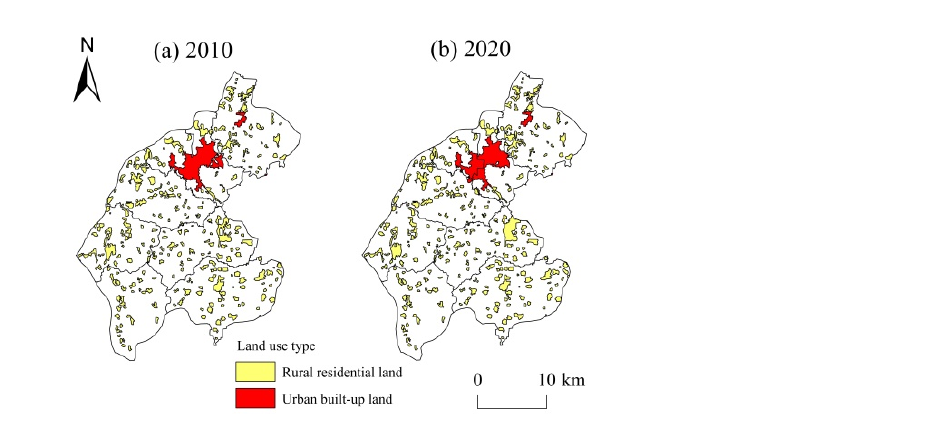
Figure 5. The distribution of rural residential land in Pingyin County from 2010 to 2020. ( a ) 2010; ( b ) 2020.